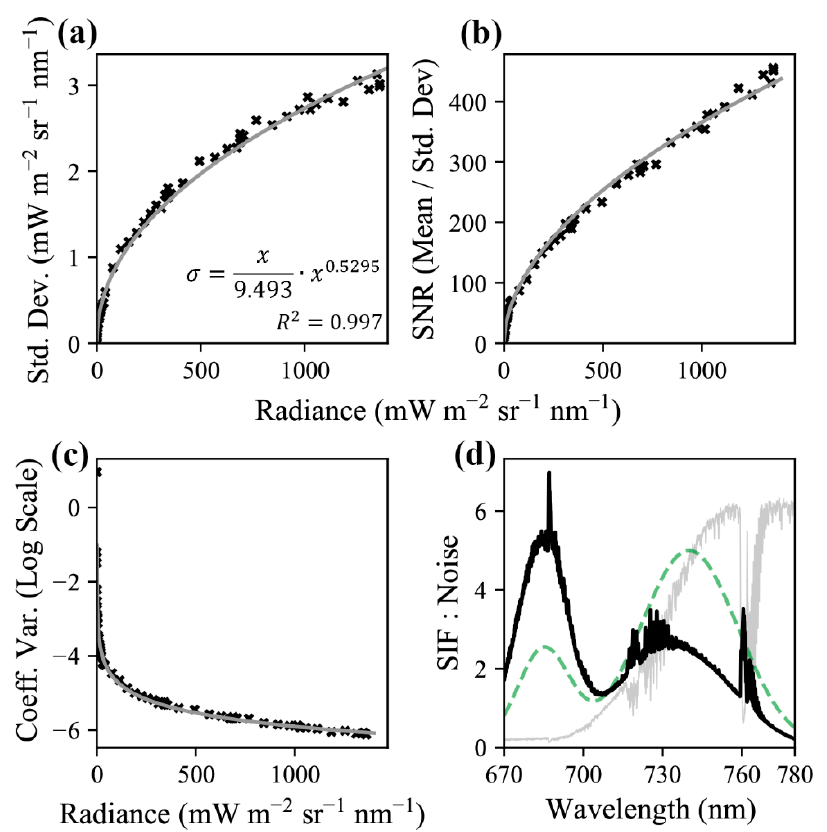
Figure 9. ( a ) The relationship (gray line) between FIREFLY radiance and standard deviation based on observations made with the integrating sphere and ASD (black x); ( b ) the relationship (gray line) between the signal to noise ratio (SNR) and radiance, based on observations made with the integrating sphere and ASD (black x); ( c ) relationship (gray line) between coefficient of variation and radiance based on sphere observations (black x); and ( d ) an example FIREFLY vegetation spectra (gray line) with an example SIF signal (green dashed line, not drawn to scale) and the ratio of SIF to the expected noise based on the radiance values from the example vegetation spectra (black line).